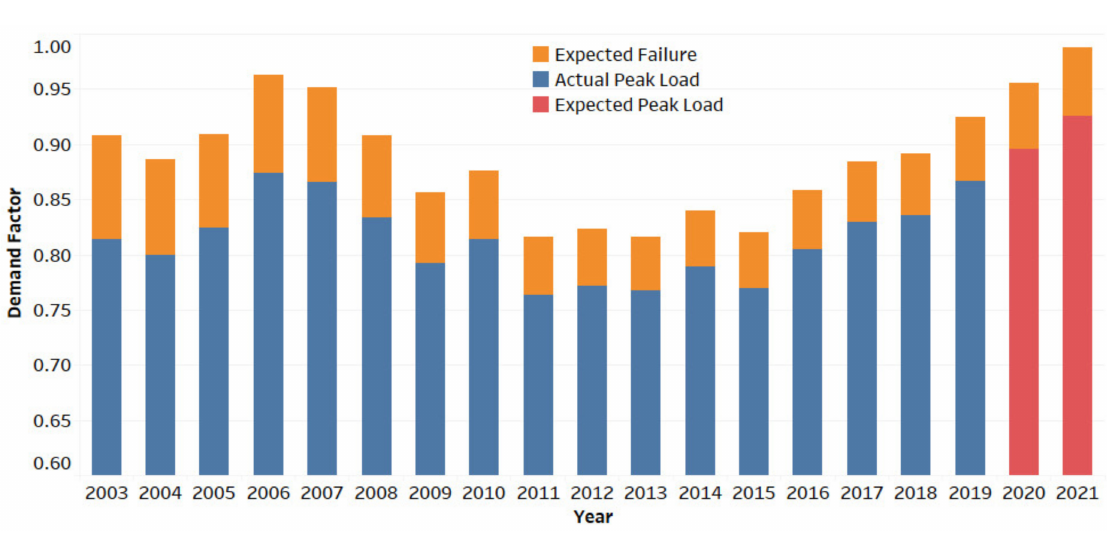
Figure 5. Demand factor in Kuwait electric national